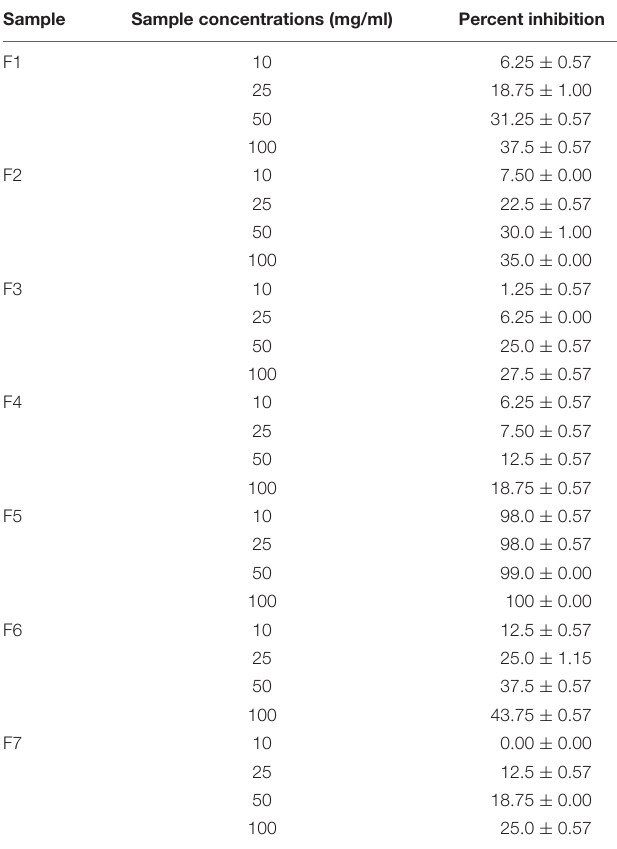
TABLE 1 | IC 50 values of Lawsonia inermis leaves extract and fractions. Sample Sample concentrations (mg/ml)